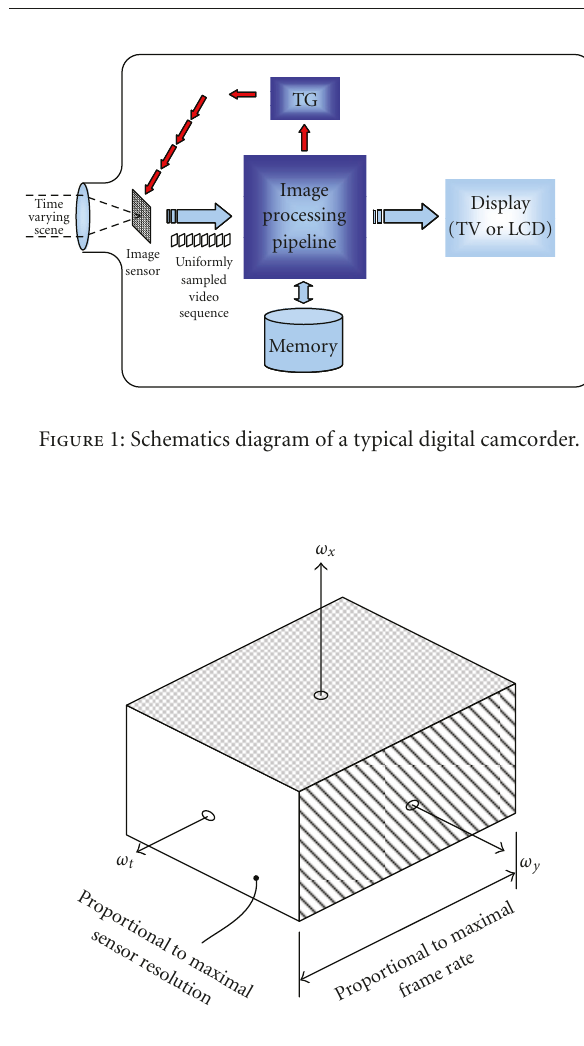
Figure 2: Sensor array potential capacity.